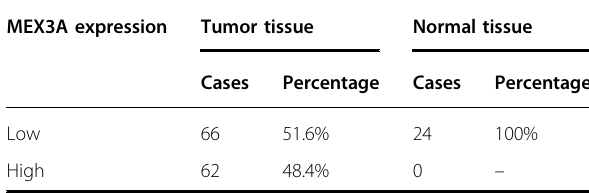
Table 1 Expression patterns of MEX3A in glioma and normal tissues revealed in immunohistochemistry